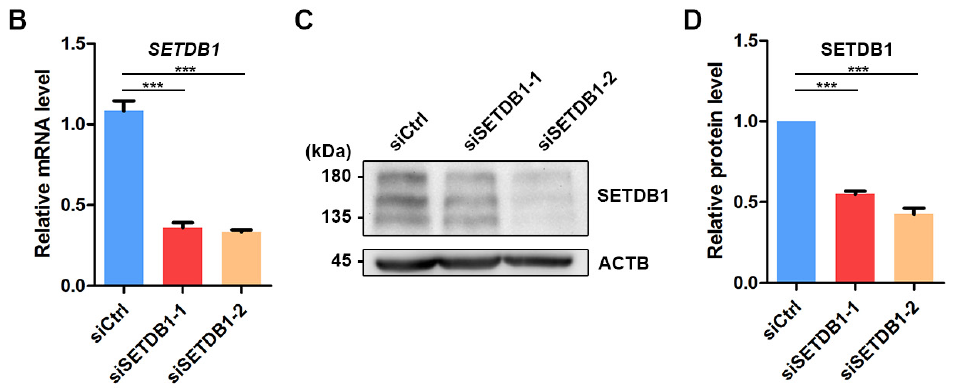
Figure 2. Knockdown of SETDB1 in porcine SSCs. ( A ) Immunofluorescence panel of VASA (red), PLZF (green), UCH-L1 (red), SV40 (green), PCNA (red), negative control (IgG; green) and DAPI (blue) in porcine SSCs. Scale bar = 50 μ m. ( B ) qRT-PCR analysis of the relative mRNA level of SETDB1 in porcine SSCs. ( C ) Western blot analysis of the protein levels of SETDB1 and ACTB in porcine SSCs. ( D ) The protein level of SETDB1 relative to ACTB. Significance was presented as *** p < 0.001. Error bars represented the standard error of the mean (SEM).